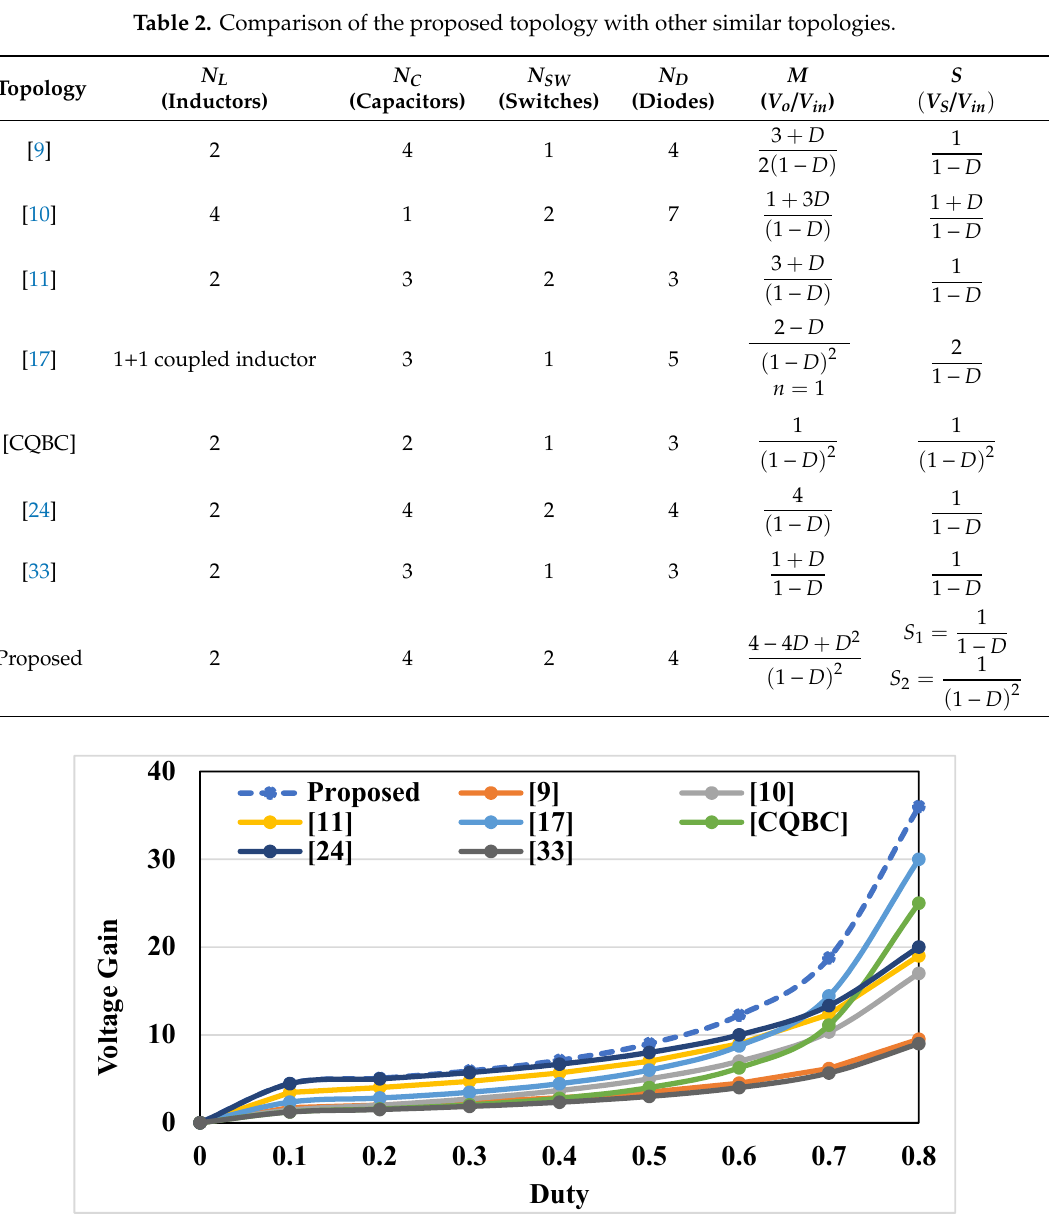
Figure 6. Comparison of Voltage gain vs. Duty ratio of proposed converter with other converters .